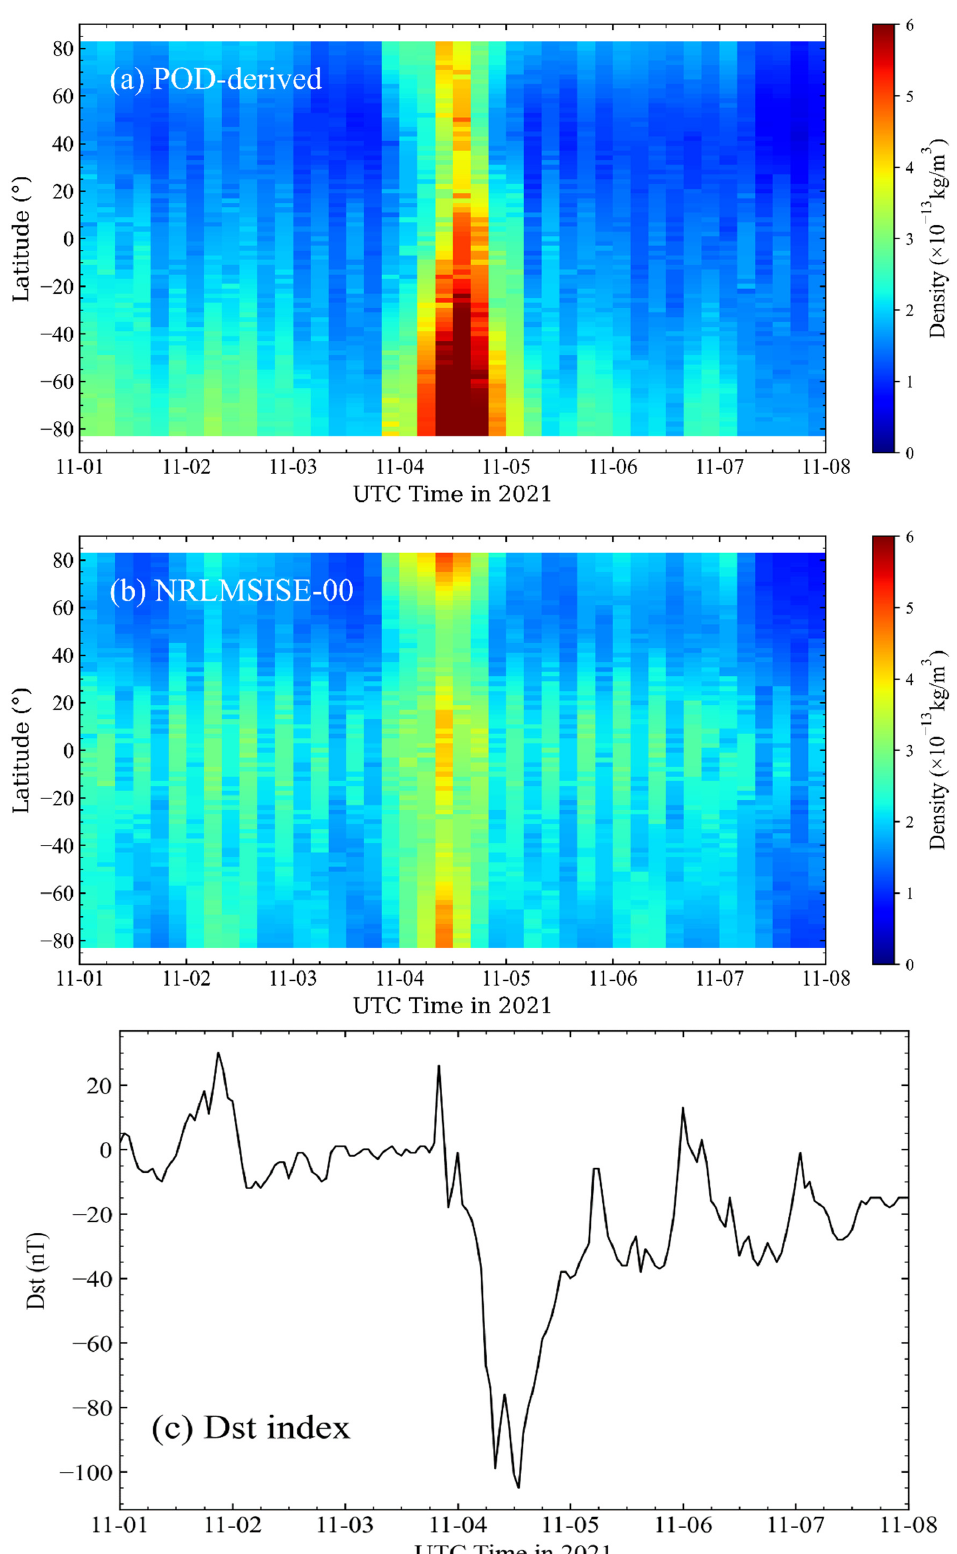
Figure 10. A spatial comparison between ( a ) the derived densities and ( b ) the NRLMSISE-00 atmospheric density model results; ( c ) the Dst index. The first epoch is noted at 00:00 h on 1 November 2021 (UTC).